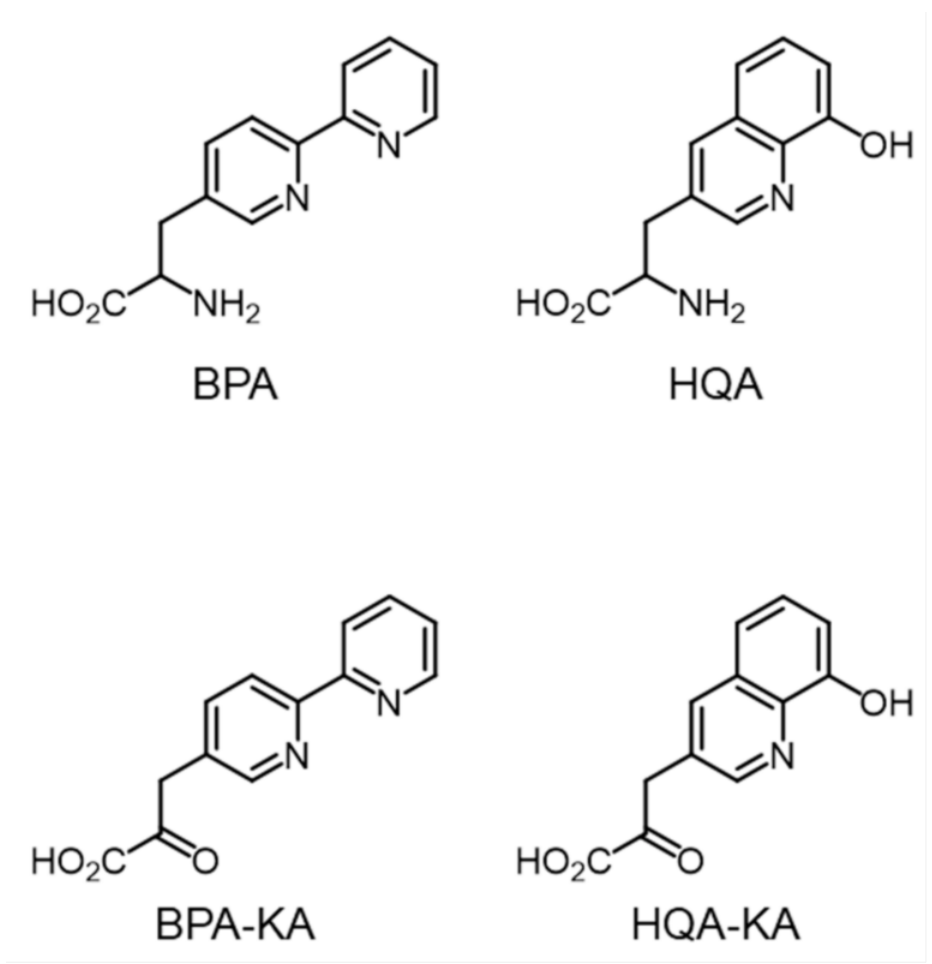
Figure 1. Structures of unnatural amino acids and keto-acids used in this